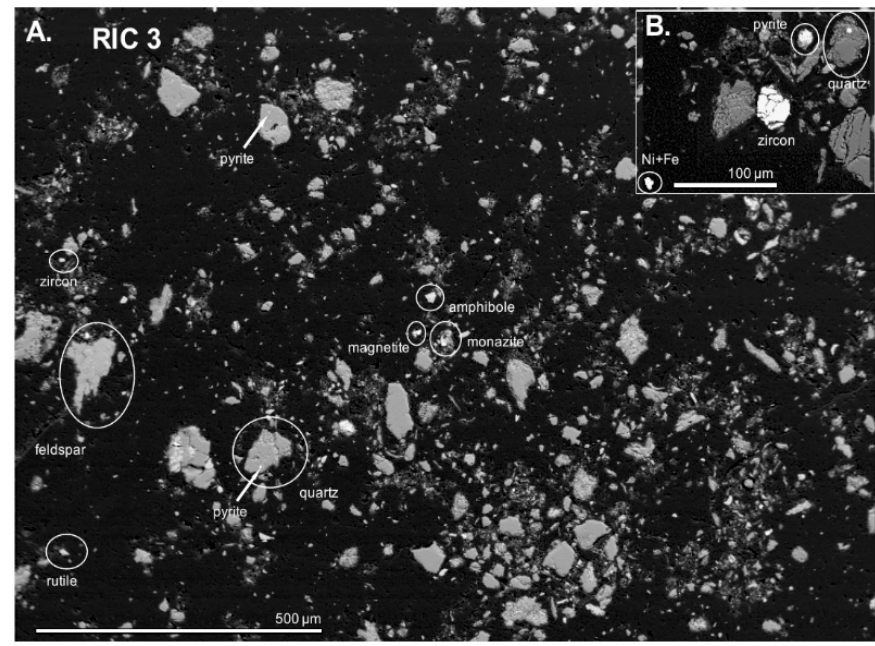
Figure 2. ( A ) Cryodust in a back-scattered electron (BSE) image of the dust sample from Recherchebreen. details). Sample RIC 3. Atmosphere 2020 , 11 , x FOR PEER REVIEW